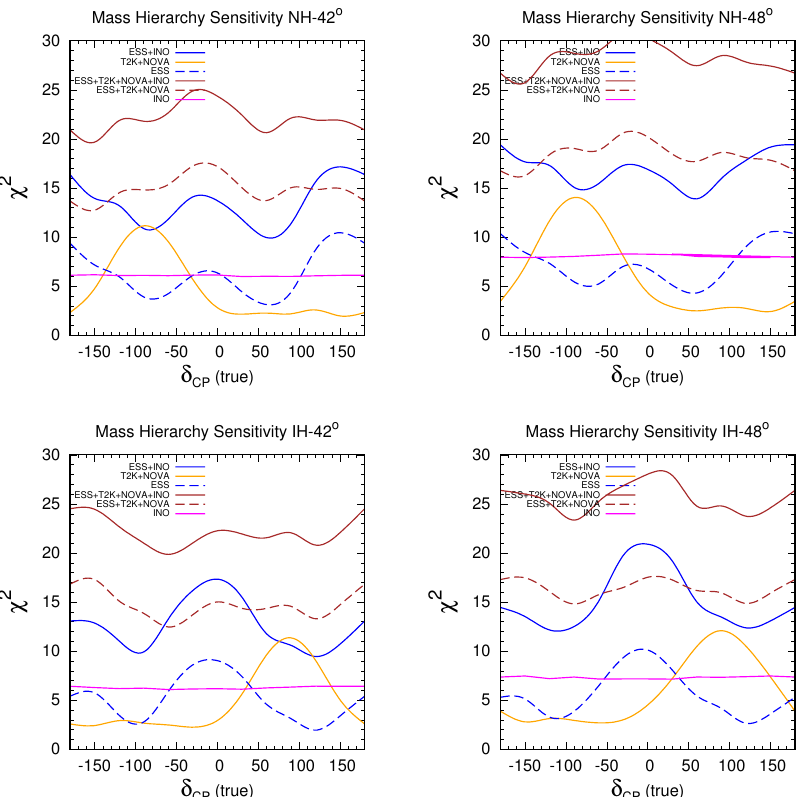
Figure 3 . Mass hierarchy sensitivity vs. (cid:14) CP (true) for ICAL@INO-3D ESS (cid:23) SB T2K NO (cid:23) A for four hierarchy-octant combinations starting from top right, clockwise in the order NH-LO, NH- HO, IH-HO and IH-LO. Each (cid:12)gure consists of six di(cid:11)erent experimental combinations which are represented as ICAL@INO (magenta solid curve), ESS (cid:23) SB (blue dashed curve), T2K + NO (cid:23) A (orange solid curve), ESS (cid:23) SB + ICAL@INO (blue solid curve), ESS (cid:23) SB + T2K + NO (cid:23) A (brown dashed curve) and ESS (cid:23) SB + T2K + NO (cid:23) A + ICAL@INO (brown solid curve).